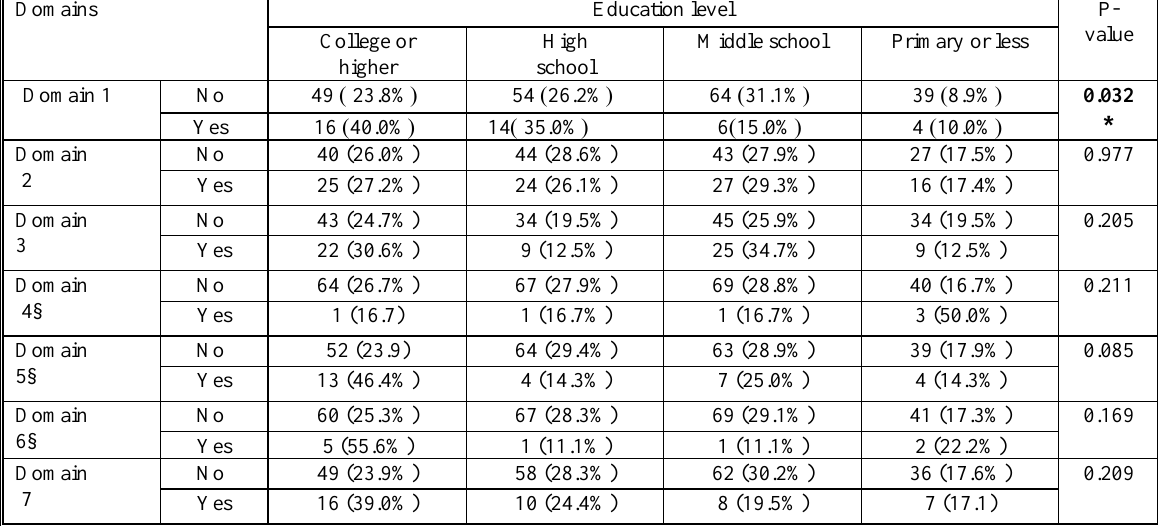
Table 5.The relationships between the patient education level and the study domains